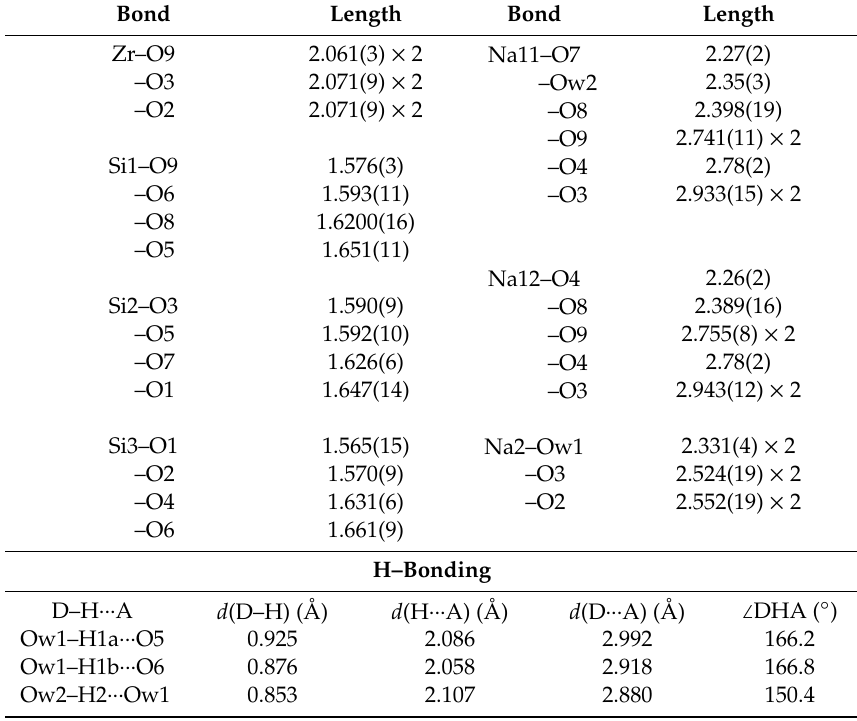
Table 5. Selected interatomic distances (Å) and H-bonding in the structure of initial elpidite from Lovozero.